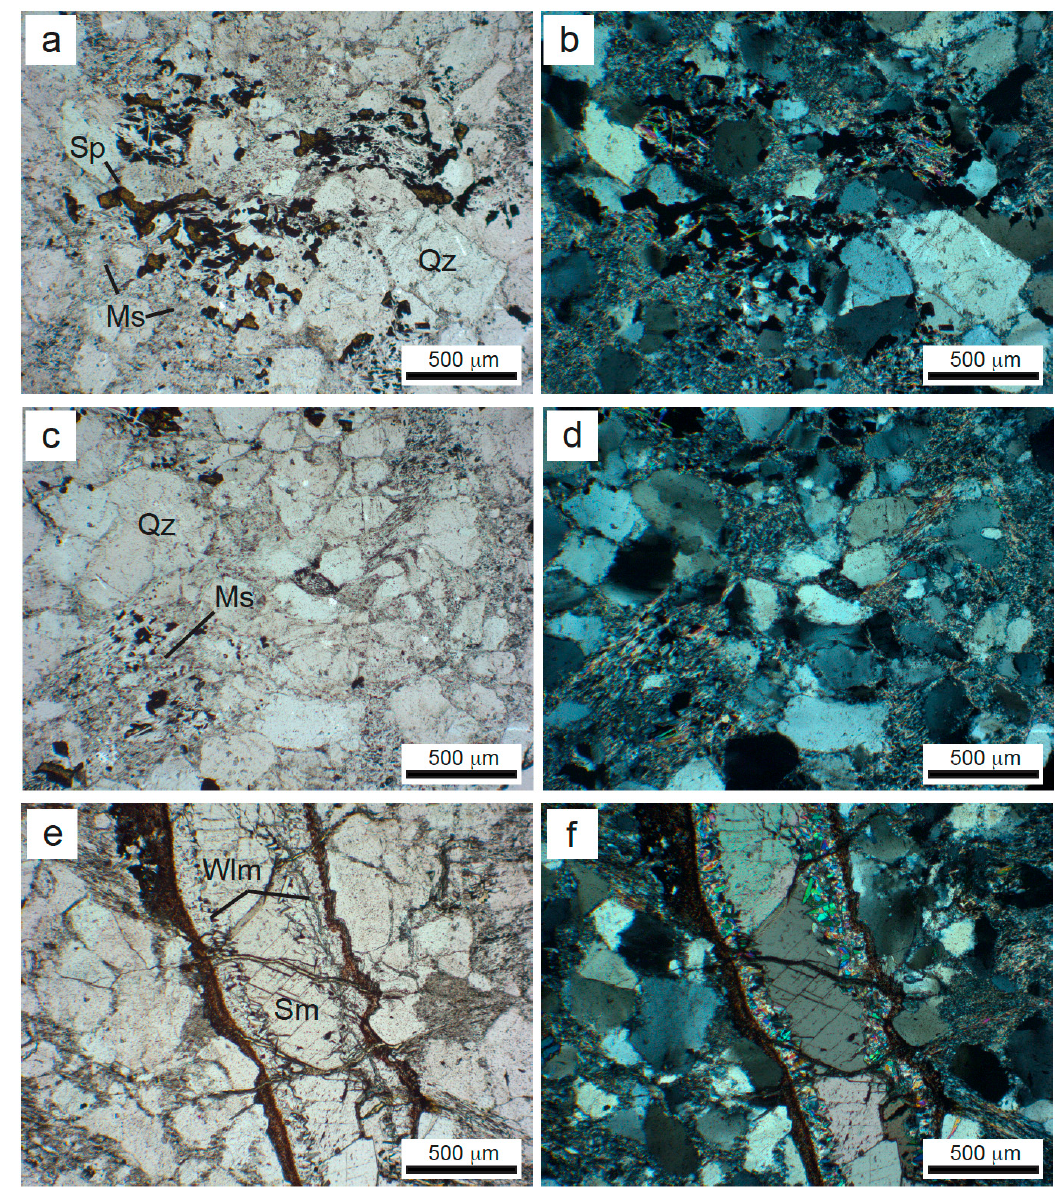
Figure 7. Transmitted light micrographs: ( a ) and ( b ) Sample KDD 125-8: Sphalerite dispersed in the quartzwacke matrix, in between micas with decussate structure (NII and N+); ( c ) and ( d ) Sample KDD 125-8: Quartzwacke with schistose structure (NII and N+); ( e ) and ( f ) Sample KDD 143-16: Vein consisting of willemite and smithsonite (NII and N+). Ms = muscovite; Qz = quartz; Sm = smithsonite; Sp = sphalerite; Wlm = willemite.